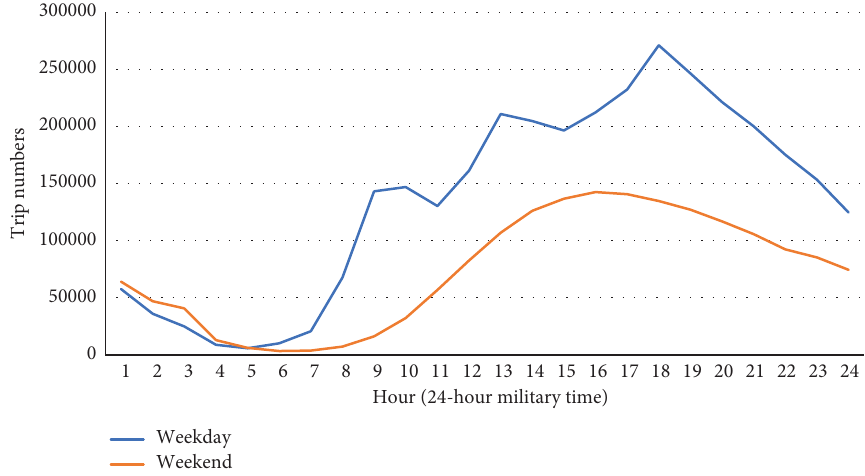
Figure 2: Hourly trips based on the day-of-week for the year 2019.